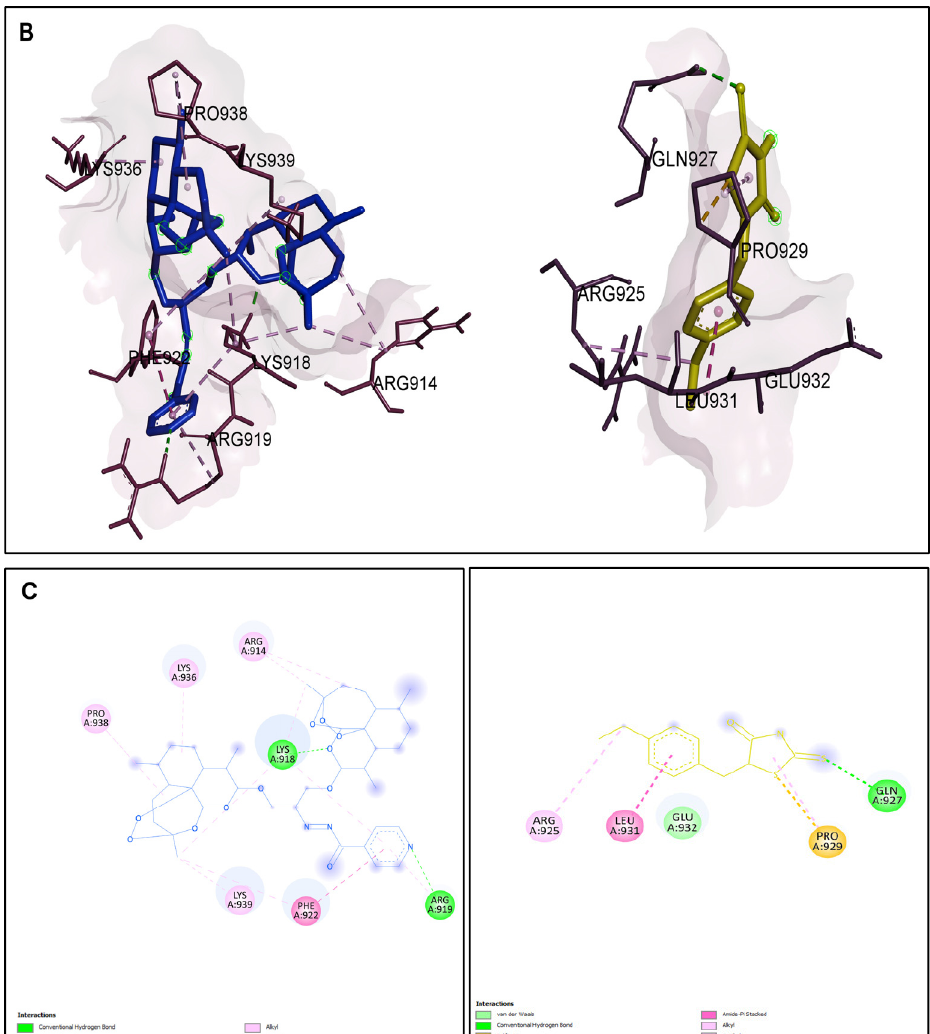
Figure 2. ( A ) Molecular docking of the dimer isoniazide and the known inhibitor 10058-F4 with c-MYC. The binding of 10058-F4 was con fi ned more to the c-MYC and MAX interaction site, while the dimer isoniazide was closer to the DNA binding site. ( B ) Three-dimensional representation of the docking interactions of the dimer isoniazide (blue) and the known inhibitor 10058-F4 (yellow). ( C ) Two-dimensional representation of the docking interactions of the dimer isoniazide (blue) and the known inhibitor 10058-F4 (yellow).